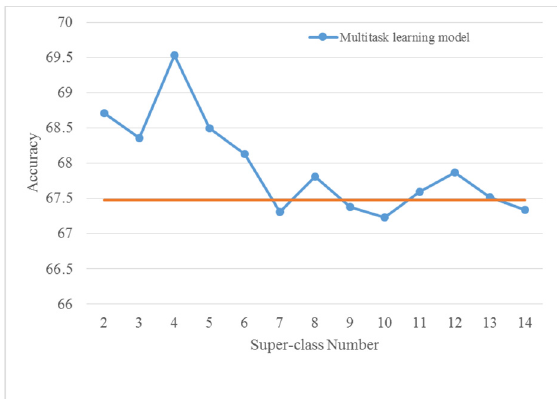
Figure 5. Accuracies of multitask learning models with different super-class numbers using CQT spectrograms on the TUT Acoustic Scenes 2017 dataset. The orange horizontal line means the accuracy of the basic model (VGG-CQT).